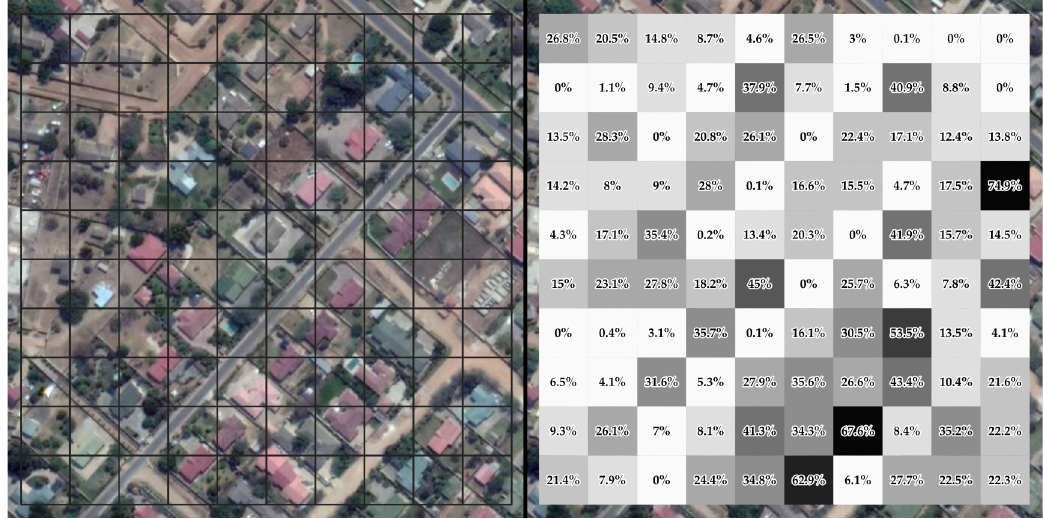
Figure 3. Percentage of Built-Up Areas per 30 m pixel in a suburban area of Lusaka,